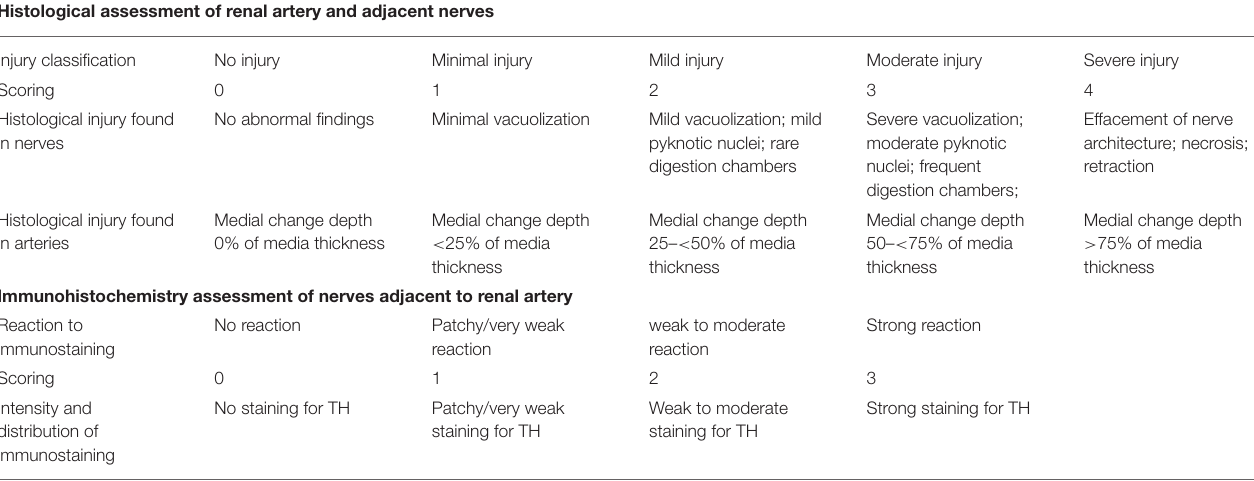
TABLE 2 | Semiquantitative Scoring System for evaluating the injury of renal artery and adjacent nerves. Histological assessment of renal artery and adjacent nerves